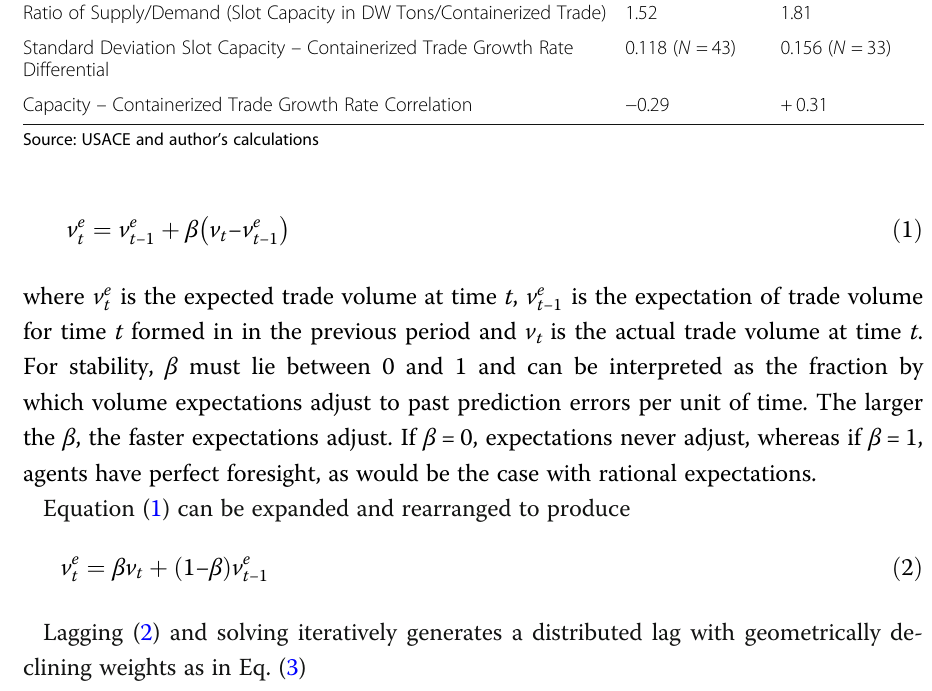
Table 2 Capacity deployed (DWT) relative to demand (trade volume) in the WTA pre- and post- antitrust block exemption Westbound Transatlantic Market Ratio of Supply/Demand (Slot Capacity in DW Tons/Containerized Trade)